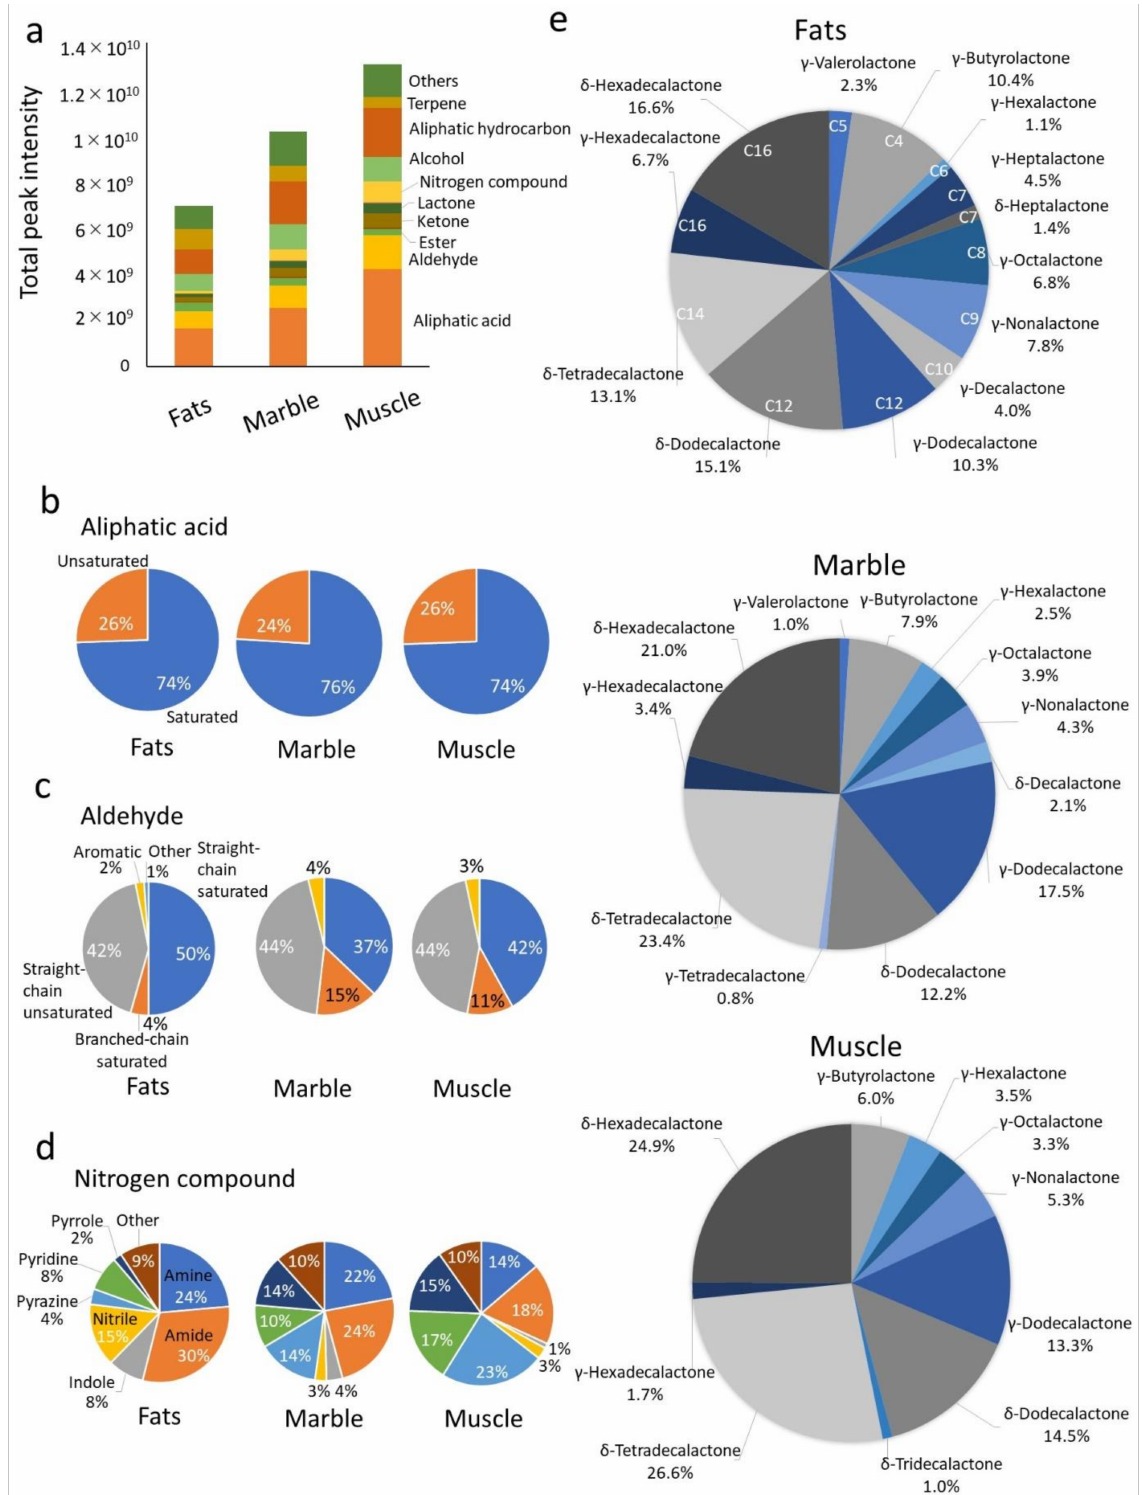
Figure 3. Analysis of aroma components generated from beef tallow by dynamic headspace–gas chromatography–mass spectroscopy. ( a ) Composition of the main functional groups of odorants in beef tallow. The bar graph shows the total intensity the summed intensities of detected compound peaks as classified by functional group. ( b – e ) Composition of lactone produced from beef tallow extracted from intermuscular fat of Japanese Black cattle. The pie chart shows the lactones produced by Fats, Marble, and Muscle. All graphs show the mean of the values obtained from three